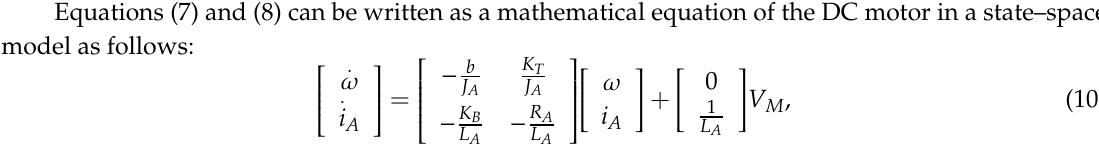
Figure 4. Diagram of the armature cycle of a DC motor.